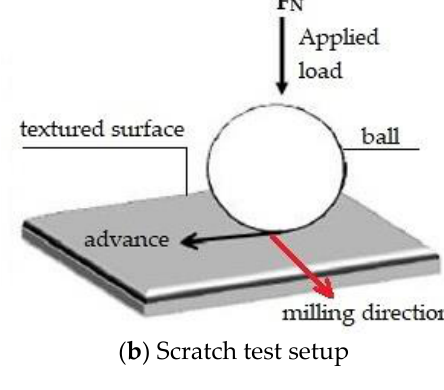
Figure 3. Scratch test configuration.